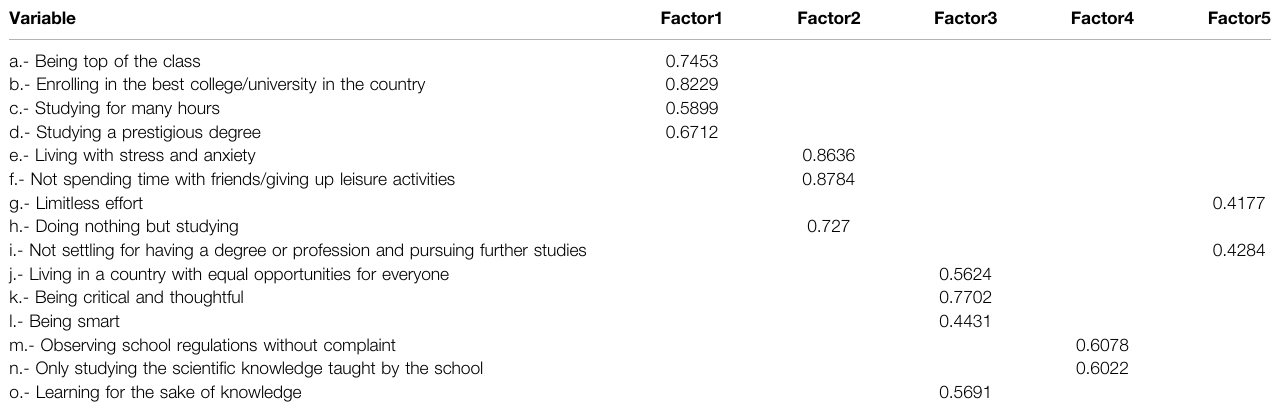
TABLE 1 | Factor loadings for varimax-rotated factor analysis of Notions on Excellence.